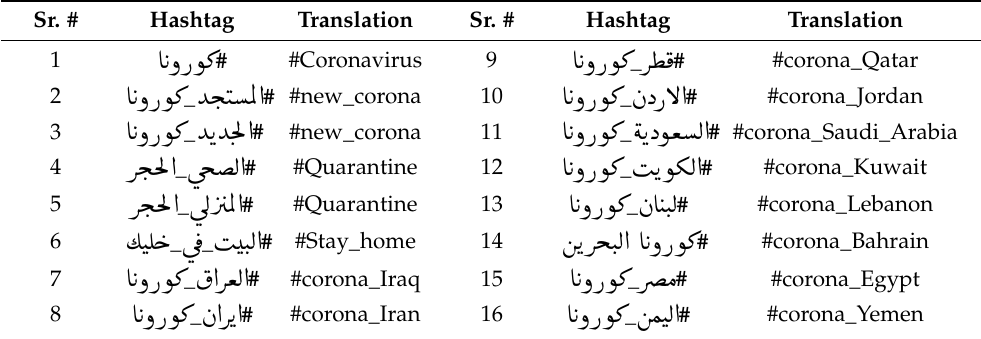
Table 1. List of hashtags.